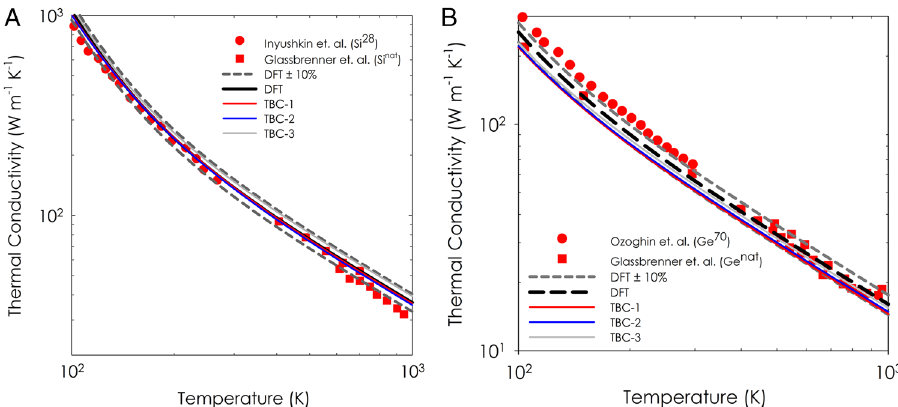
Fig. 3 TBC, DFT, and experimental 59, 60 thermal conductivity vs. temperature. a Thermal conductivity as a function of temperature for c-Si with DFT, experimental, 59, 60 and TBC POPs. b Thermal conductivity as a function of temperature for c-Ge with DFT, experimental, 59, 61 and TBC POPs. The TBC POPs were able to consistently obtain thermal conductivities within 10% of DFT